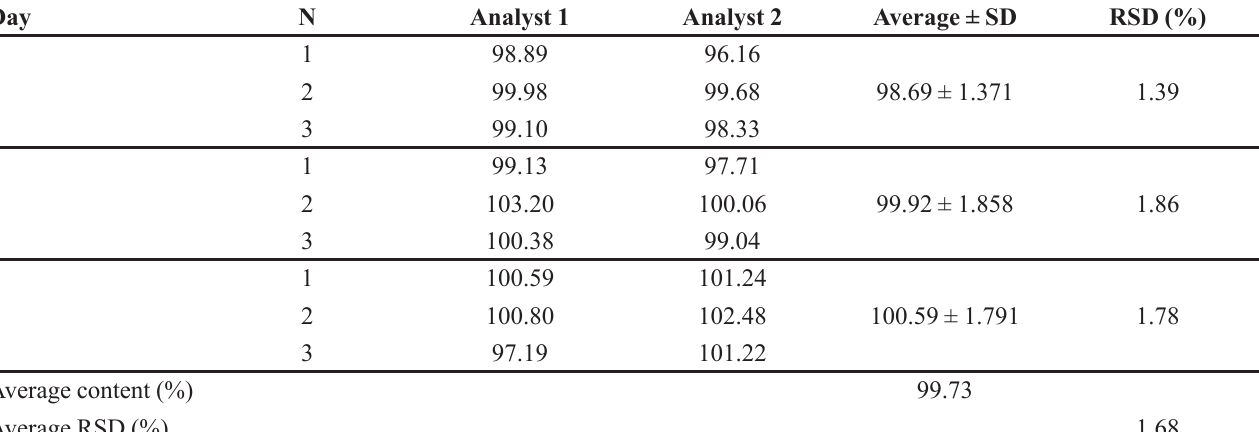
TABLE II - Values obtained for the intermediate precision determination for MUP-loaded polymeric nanocapsules with rosemary oil Day